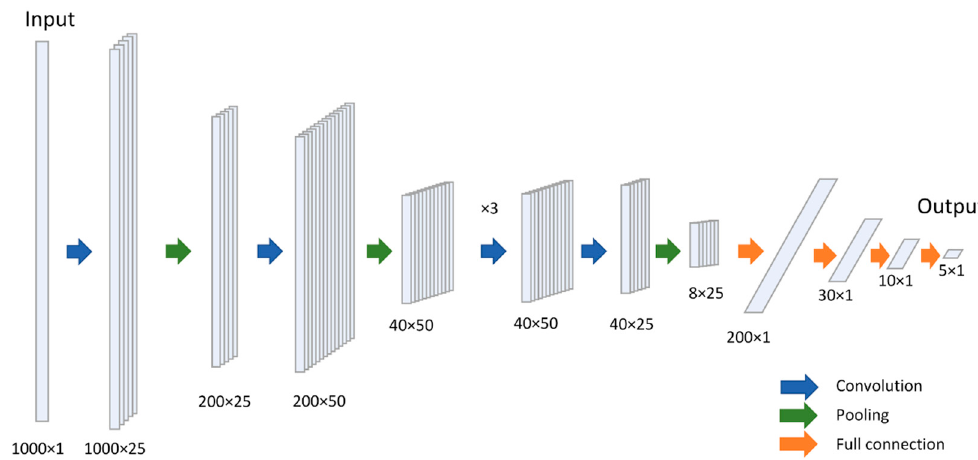
Figure 5. The architecture of CNN.